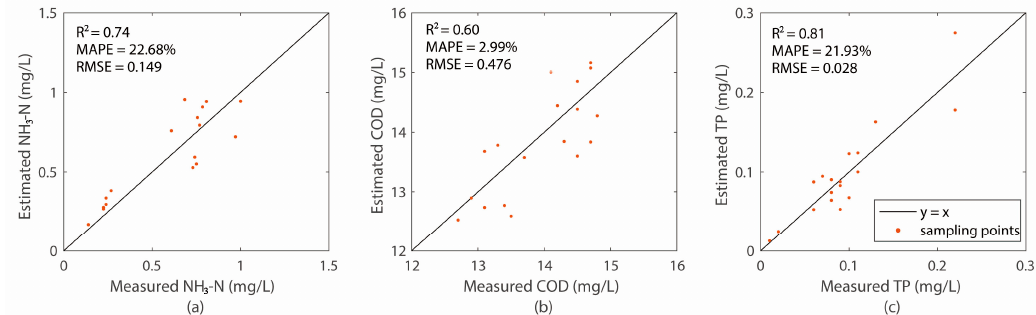
Figure 8. Accuracy assessment results of NH 3 -N, COD and TP estimated based on the machine learning model. The X -axis is the measured data, and the Y -axis is the estimated data. ( a ) Comparison of measured and estimated NH 3 -N; ( b ) comparison of measured and estimated COD; ( c ) comparison of measured and estimated TP.